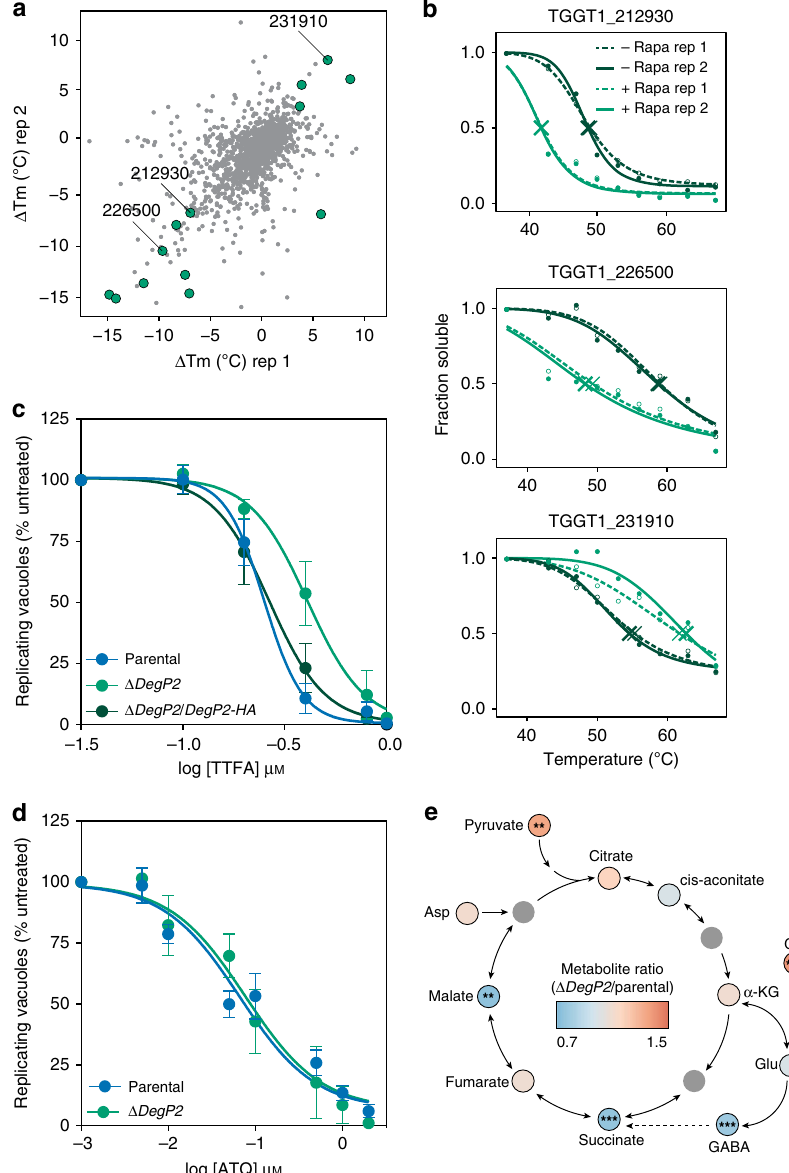
Fig. 6 DegP2 in fl uences the intersection of heme biosynthesis, the TCA cycle, and the ETC. a TPP revealed that depleting DegP2 reliably changed the melting temperatures of 13 proteins (highlighted in green, p < 0.2 by z -test in each of two replicates). Three mitochondrial proteins are indicated by their gene IDs. b Melting curves for three mitochondrial proteins identi fi ed as hits by TPP. c Dose – response curve for parasites treated with the complex II inhibitor TTFA. Results are mean ± SEM for n = 4 or 3 independent experiments, for the parental and Δ DegP2 or Δ DegP2 / DegP2-HA strains, respectively. Δ DegP2 is signi fi cantly more resistant to TTFA compared to the parental; p < 0.0001 from extra-sum-of-squares F -test. d Dose – response curve for parasites treated for 5 h with increasing concentrations of atovaquone (ATQ). Results are mean ± SEM for n = 5 or 3 independent experiments for the parental or Δ DegP2 strains, respectively. Both strains displayed similar susceptibility to ATQ; p = 0.59 from extra-sum-of-squares F -test. e Summary of changes in metabolites between parental and Δ DegP2 parasites in the TCA cycle and closely related pathways. Full results can be found in Supplementary Data 6. Asp aspartate, α -KG α -ketoglutarate, Gln glutamine, Glu, glutamate. Asterisks indicate signi fi cant change from parental, * p < 0.05, ** p < 0.005, *** p < 0.0005, by two-way